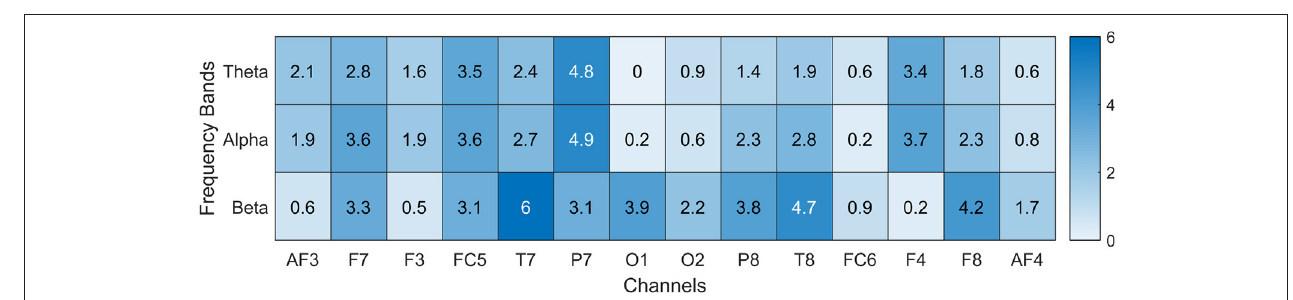
FIGURE 7 | Frequency of appearance of each indicator. Each indicator was weighted according to its ranking (e.g., rank = 1 weight = 1, rank = 2 weight = 0.9) and number of occurrences in the list.